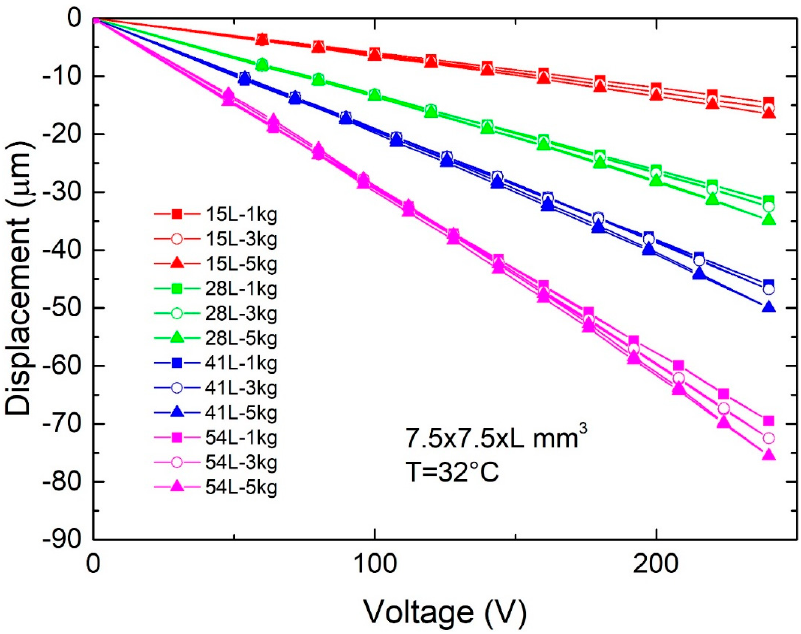
Figure 7. Same as Figure 6 but tested at 32 °C.